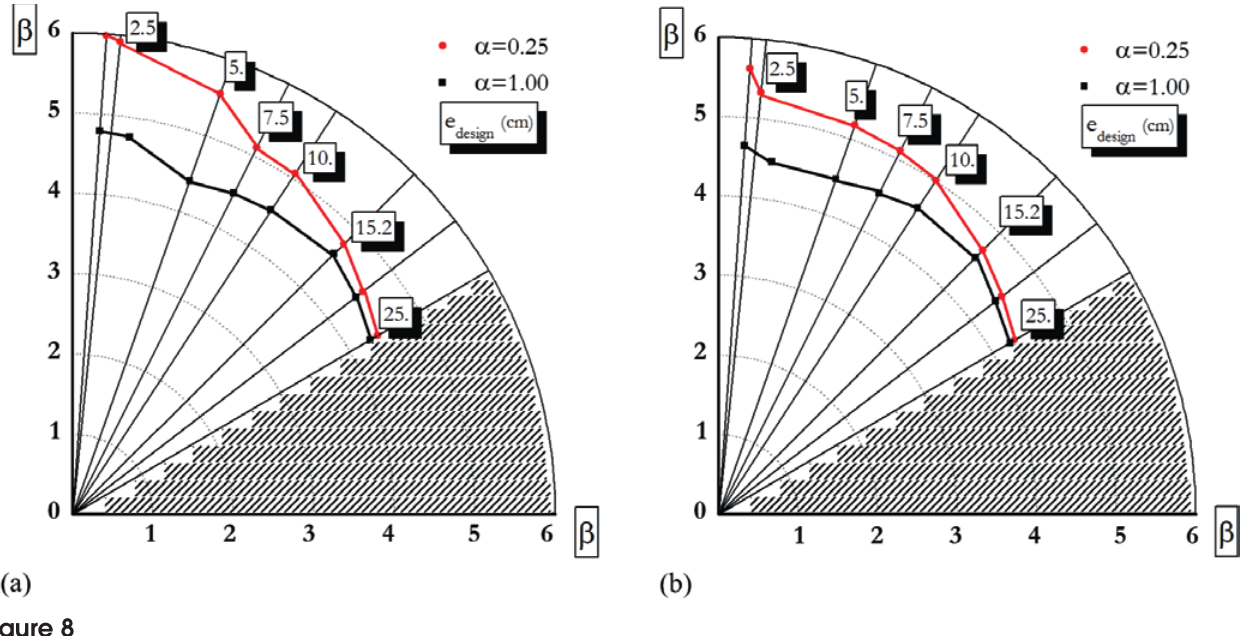
Reliability index diagrams for analysis strategies: a) A and b)